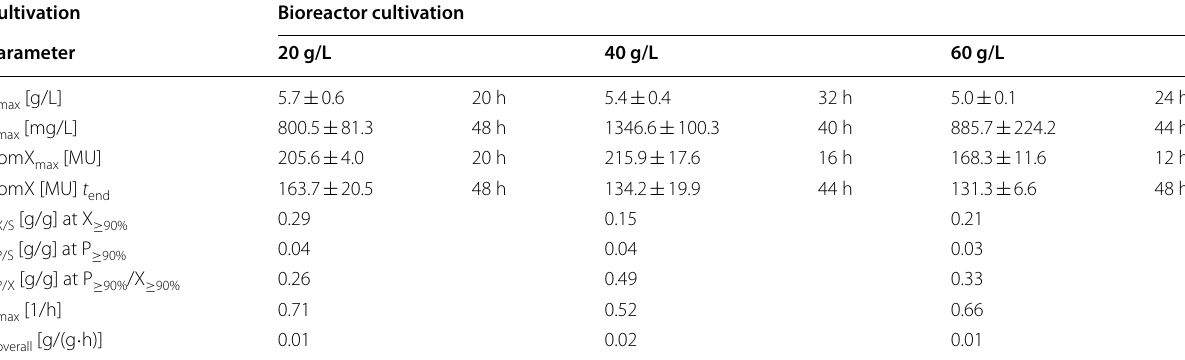
Table 1 Overview of process parameters of bioreactor batch cultivations, including yield coefficients, highest surfactin titer P